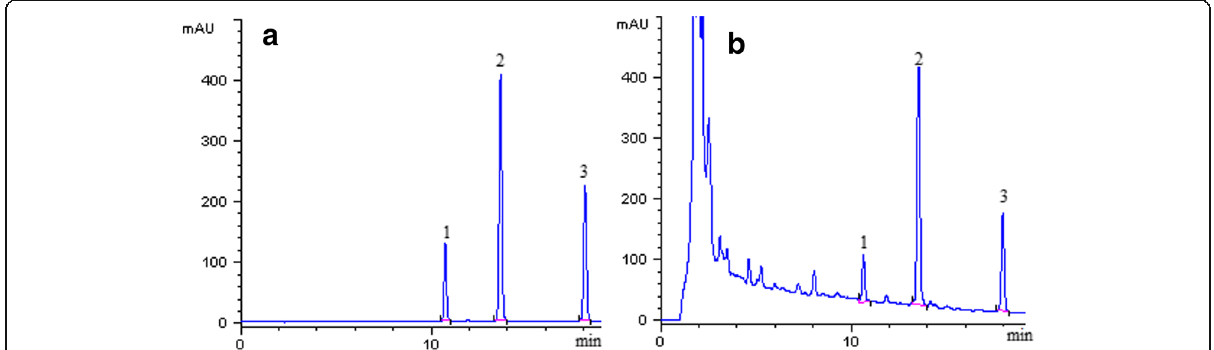
Fig. 4 Representative HPLC chromatogram of the standard solution at middle concentration ( a ) and real sample extracted from S. ningpoensis ( b ). 1 = angoroside C; 2 = cinnamic acid; 3 =